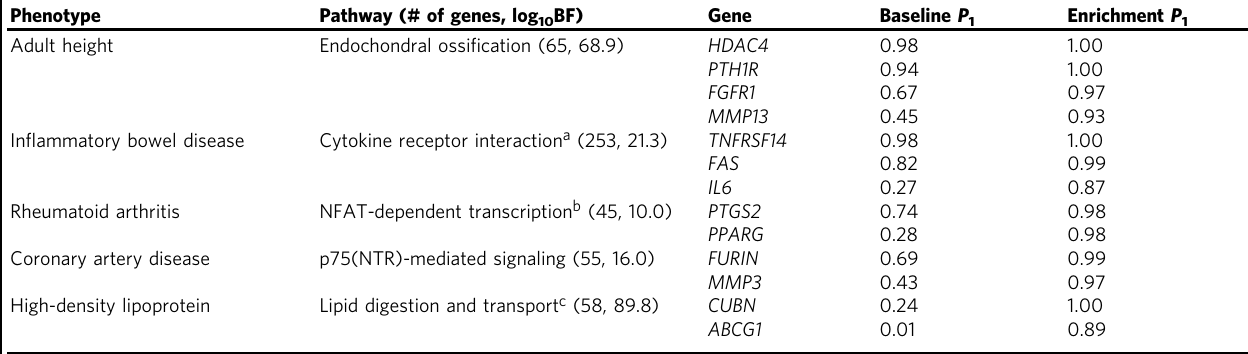
Table 2 Select putative gene-level associations from prioritization analyses